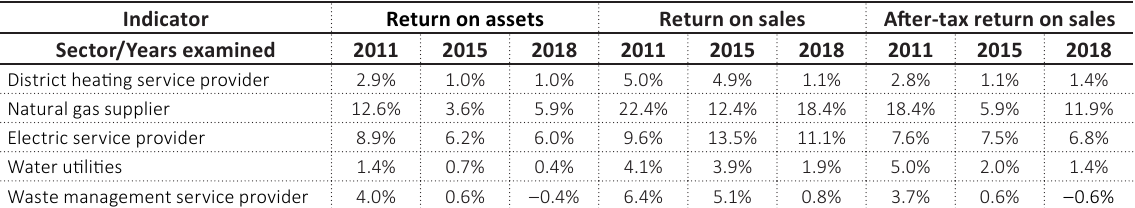
Table 3. Changes in the profitability and efficiency of corporations examined in 2011, 2015 and 2018 (data are in numerical values)